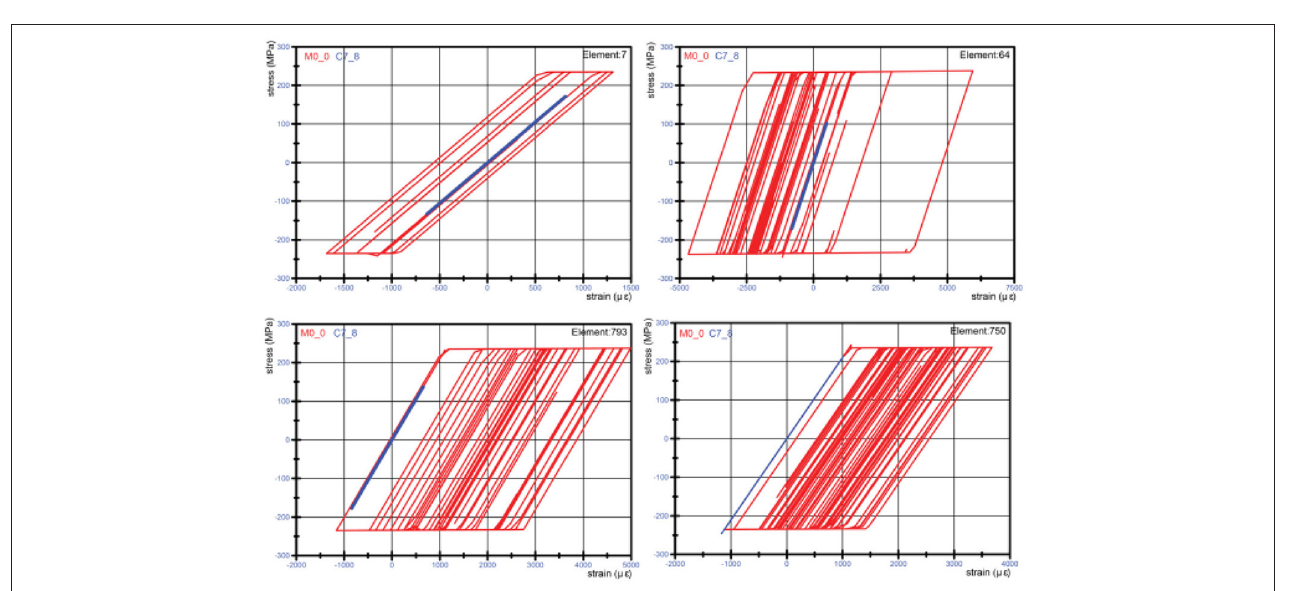
FIGURE 21 | Stress-strain relationship of a plastic element (hinge) for the structure without dampers and the structure with optimal solution.